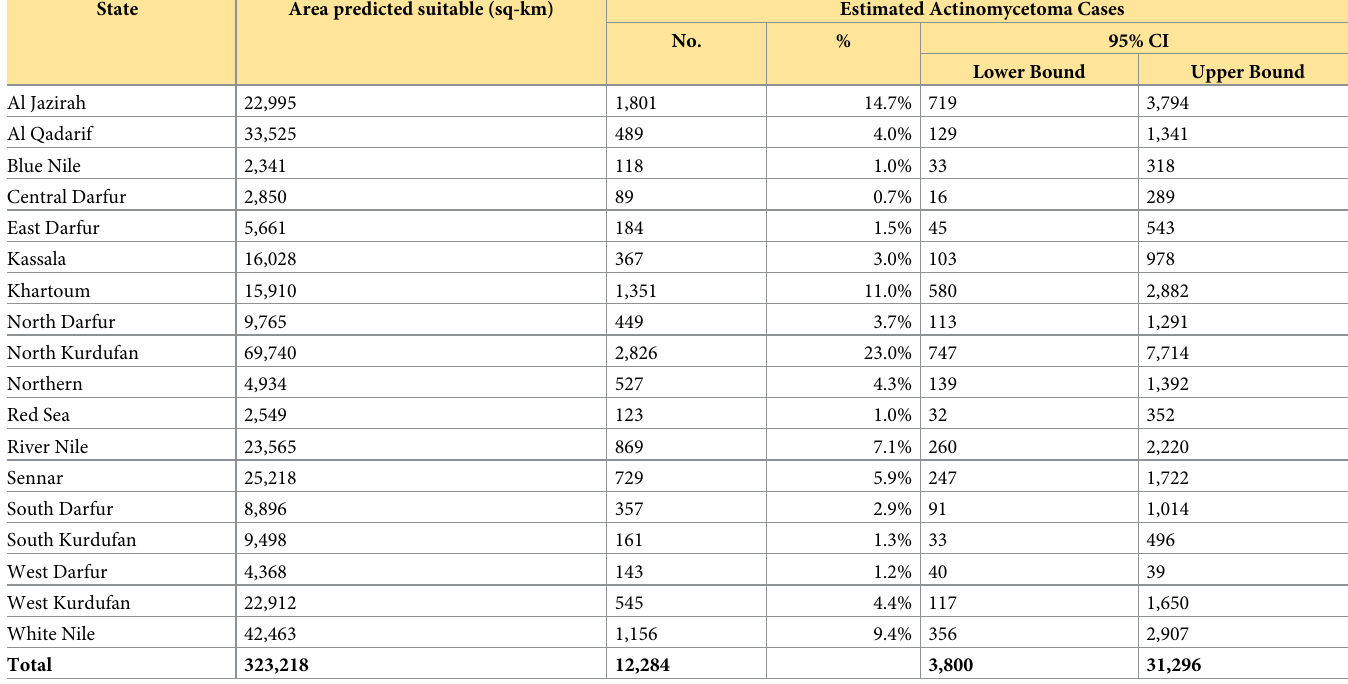
Table 2. Estimation of actinomycetoma cases by state in Sudan between 1991 and